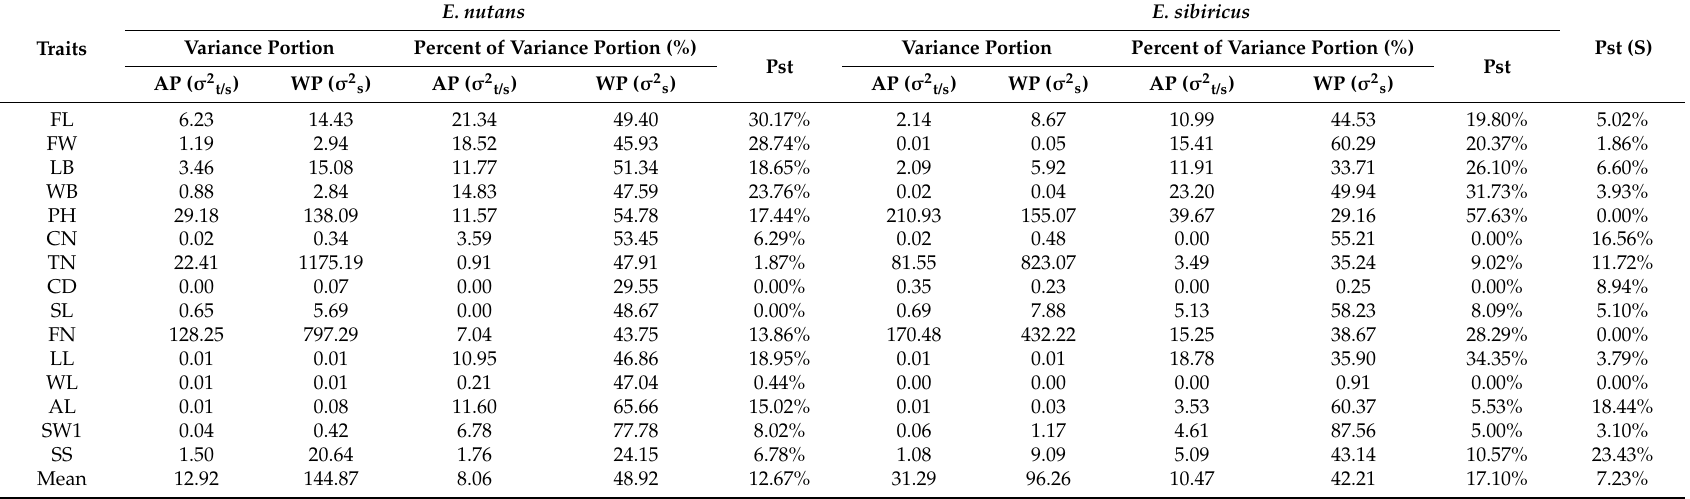
Table 1. Variance portion of each trait among geographic groups (AP) and within geographic groups (WP), phenotypic differentiation coefficient (Pst) for 15 traits within and between two Elymus species (Pst